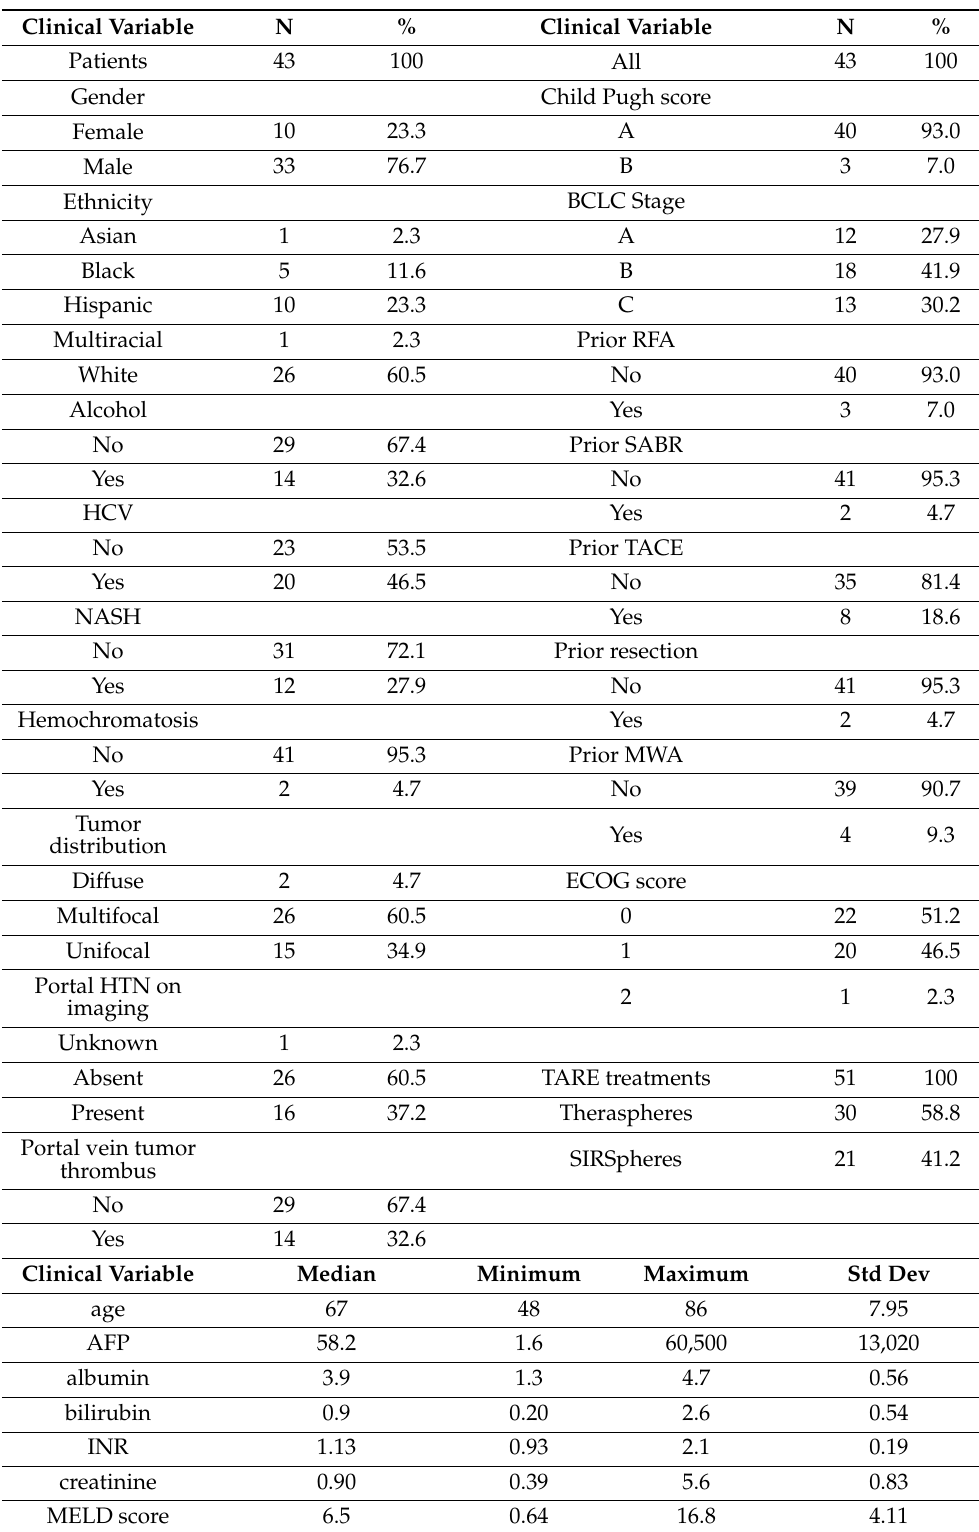
N number; HBV hepatitis B virus; HCV hepatitis C virus; NASH nonalcoholic steatohepatitis; BCLC Barcelona clinic liver cancer; RFA radiofrequency ablation; SABR stereotactic ablative radiotherapy; TACE transarterial chemoembolization; MWA microwave ablation; ECOG Eastern Cooperative Oncology Group; TARE transarterial radioembolization; AFP alpha-fetoprotein; INR international normalized ratio; MELD model for end-stage liver disease; Std Dev Standard Deviation; HTN